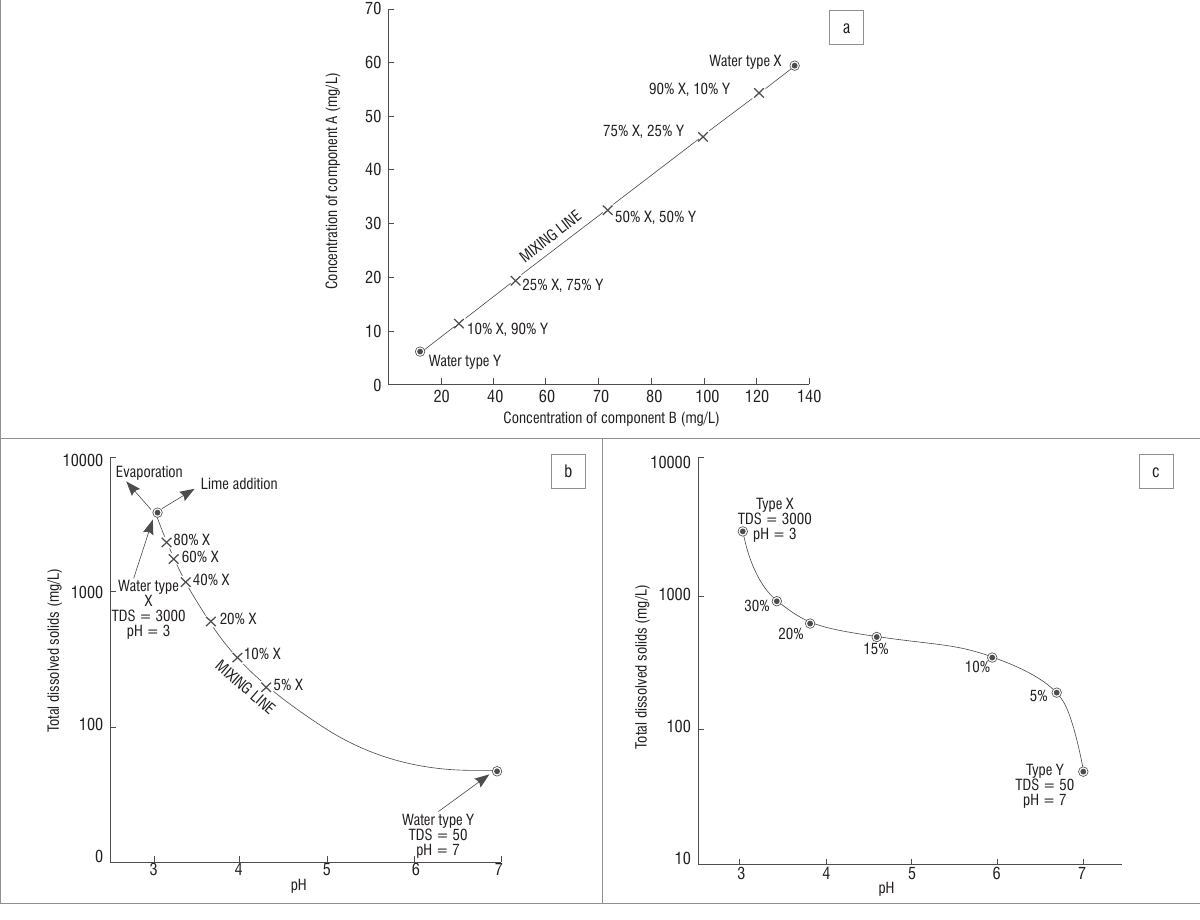
Figure 13: (a) Binary concentration plot showing the linear array resulting from the mixing of water samples of different compositions (types X and Y). (b and c) Plots of total dissolved solids against pH showing the array formed by mixing of an acidic contaminant (type X) with (b) unbuffered, uncontaminated water (type Y) and (c) uncontaminated water having the buffering characteristics of the Boesmanspruit water (type